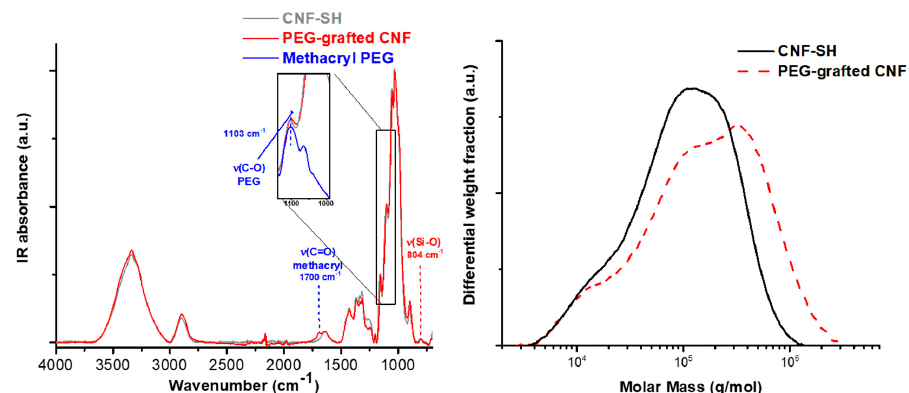
Figure 6. Thiol-ene grafting of methylacryl poly(ethylene glycol) (PEG) onto a cellulose nanofibril surface, IR spectrum ( left ) and the gel permeation chromatography (GPC, right ).